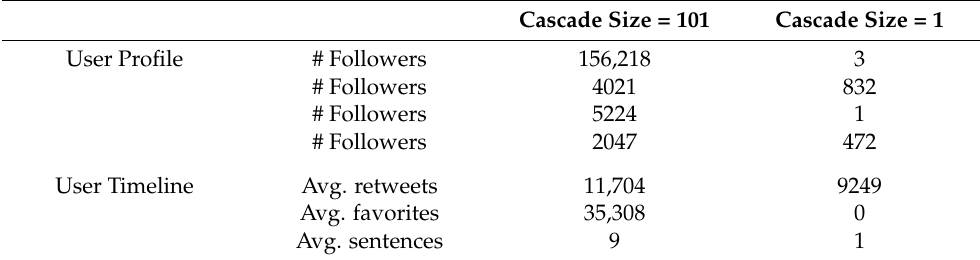
Table 6. User statistics of two source tweets having large and small cascade